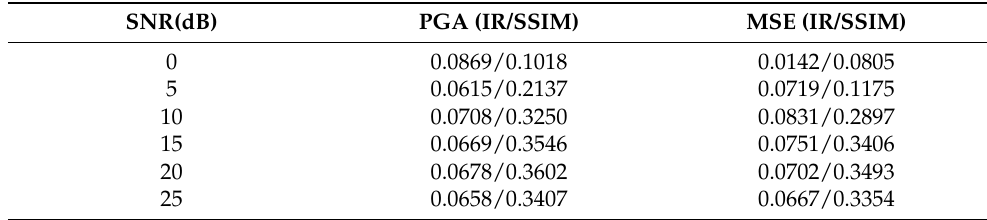
Table 4. The metrics of TAMs at different